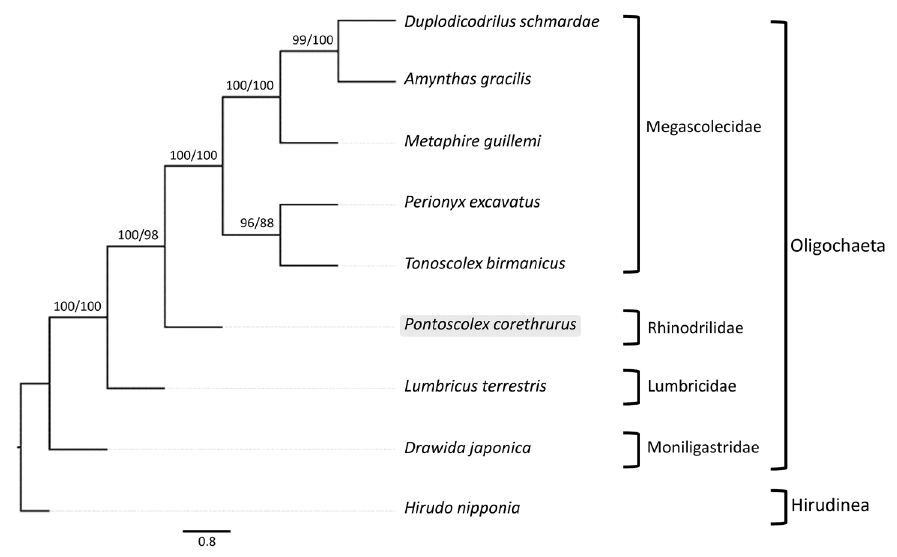
Figure 2. Phylogenetic relationships among phylum Annelida based on the combined 13,416 bp nu- cleotide positions. Total alignment length is greater than the combined P. corethrurus protein coding and rRNA sequence lengths due to overlapping protein coding sequences that are subsequently concatenated, and indel regions in the alignment. The posterior probability value of BI analyses and bootstrap support values of ML analyses (in the order: BI, ML) are indicated near the